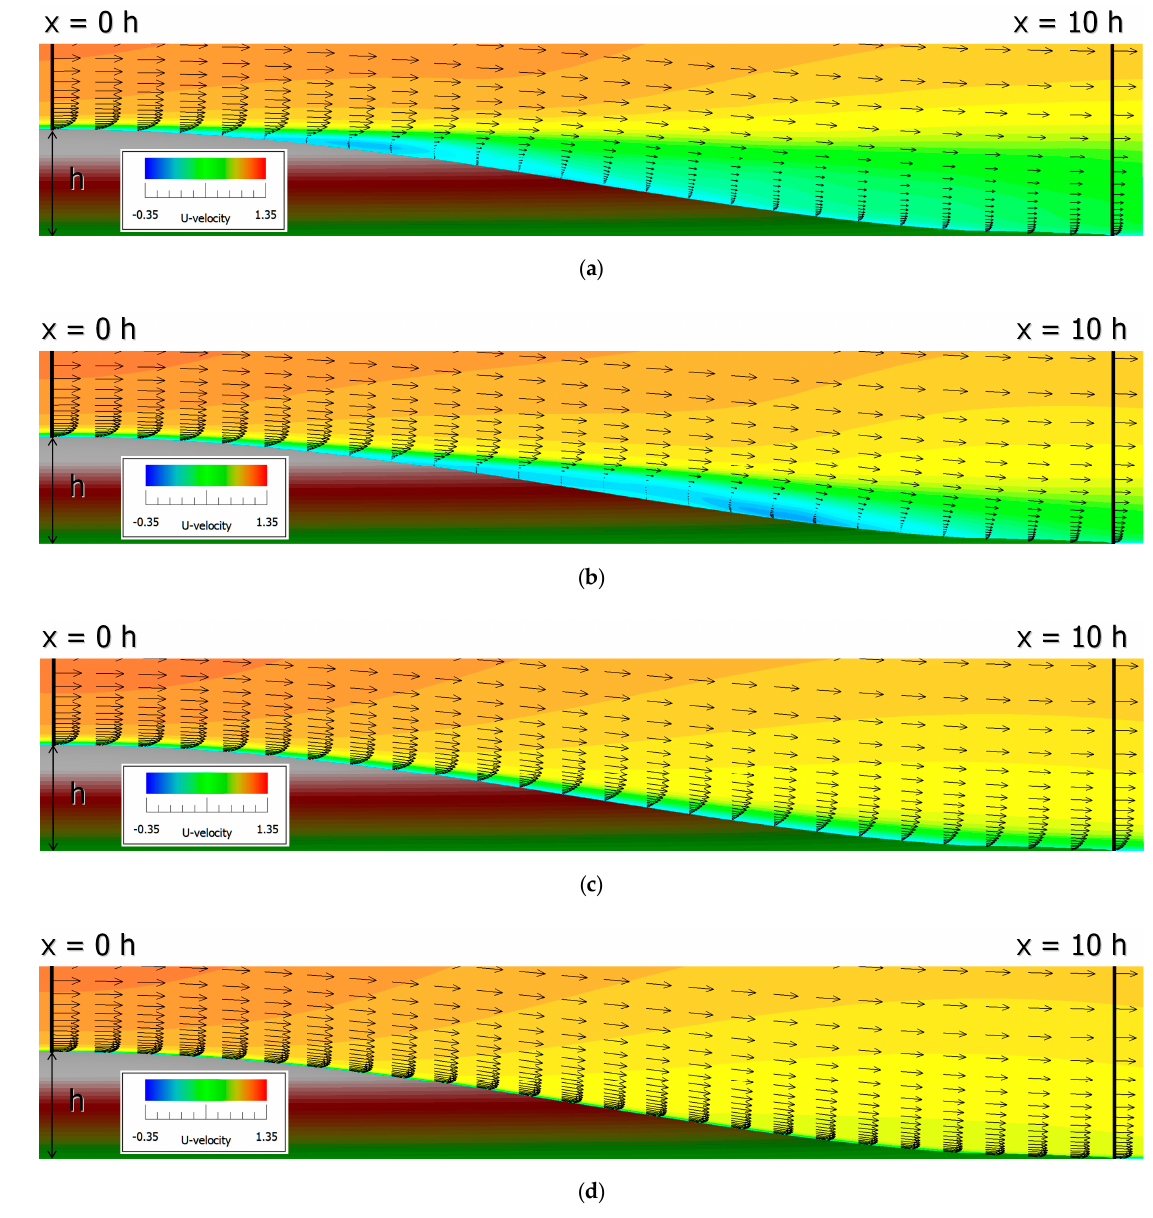
Figure 17. Comparison of flow patterns for a time-averaged flow field under various stable conditions in the gentle hill scenario. ( a ) Ri = 0.0 (neutral flow); ( b ) Ri = 0.1 (stable stratified flow); ( c ) Ri = 0.2 (stable stratified flow); ( d ) Ri = 1.0 (stable stratified flow).